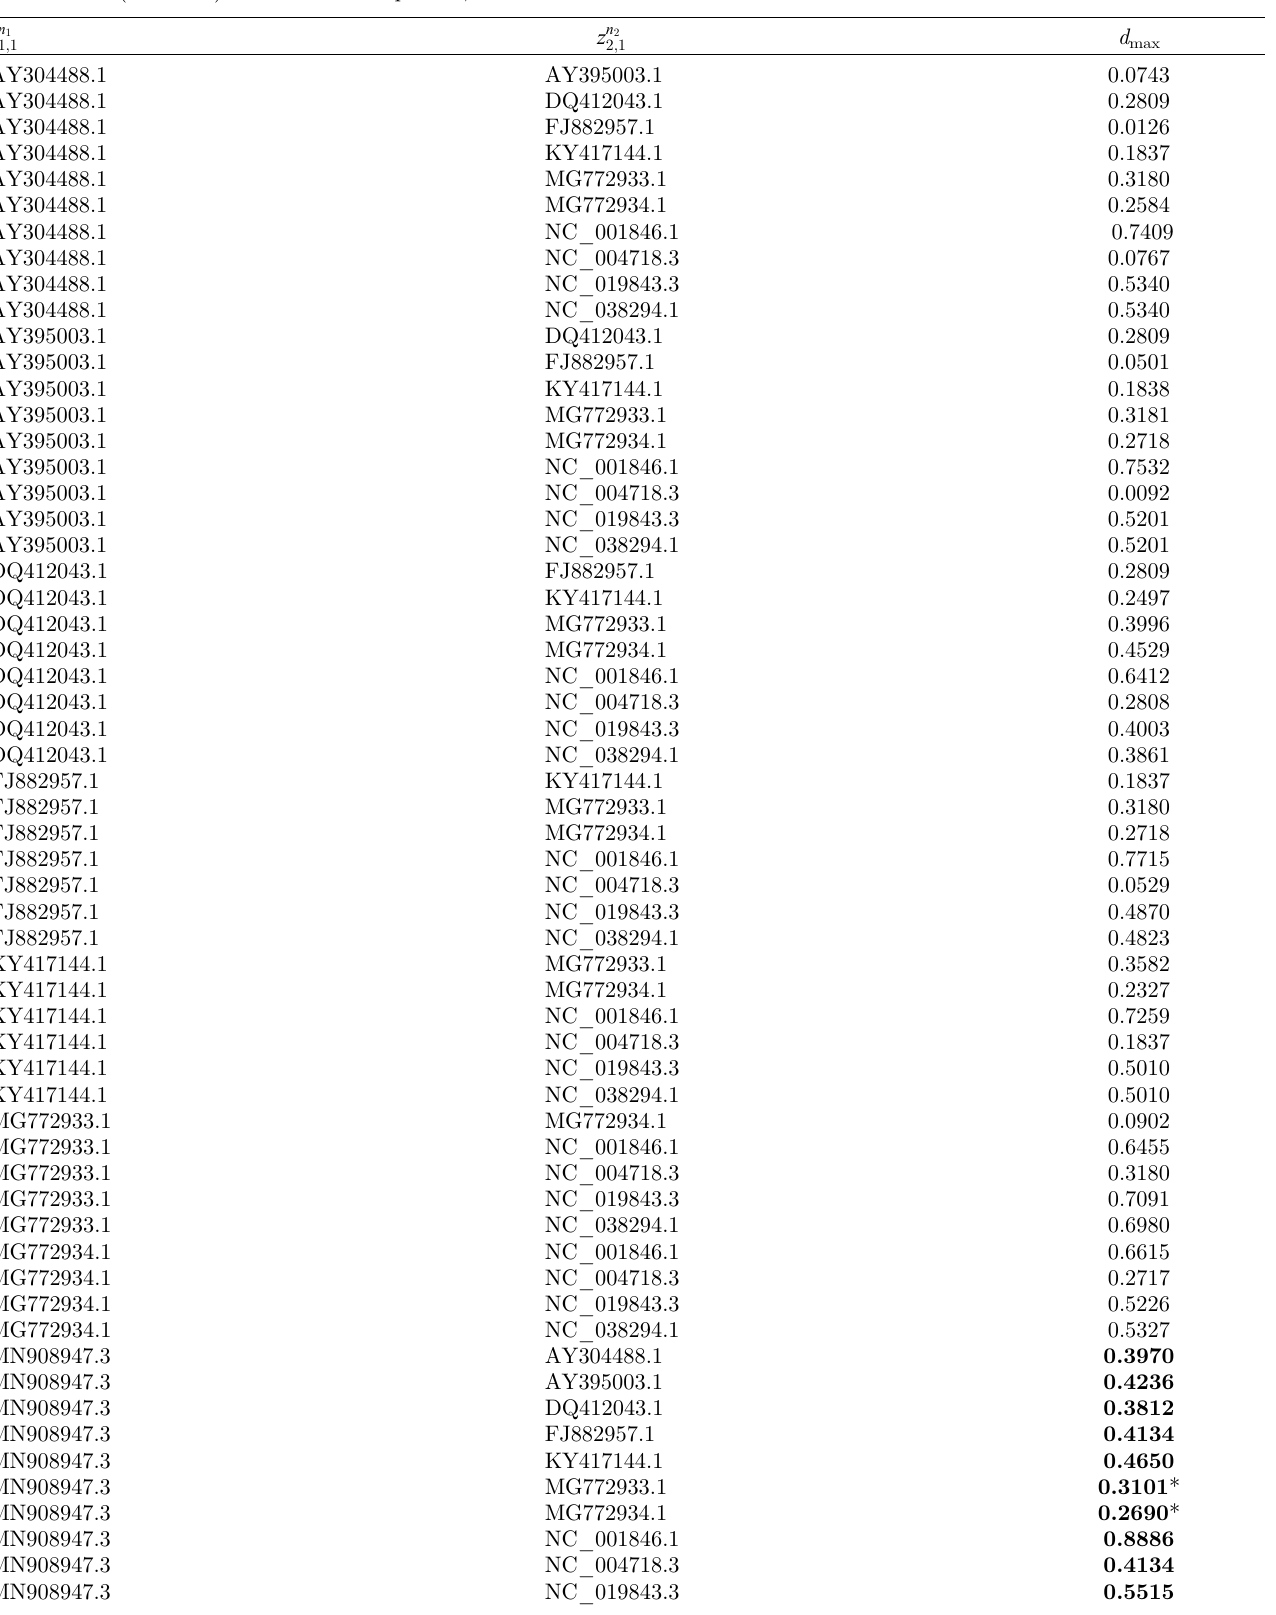
Table 10. d max values (see De fi nition 3.1) between each pair of sequences, o = 3, G = 9, a = 2. In bold type, the values between MN908947.3 (Covid-19) and the other sequences, with * the smaller